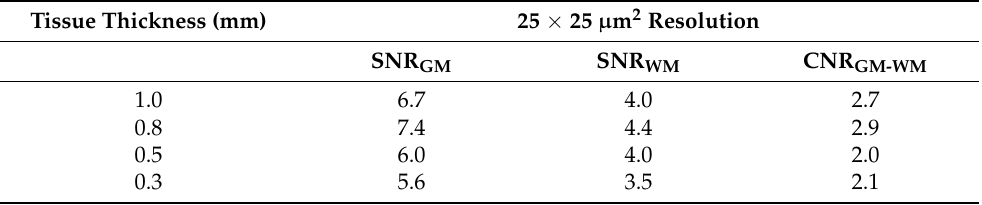
Table 1. Signal-to-noise and contrast-to-noise values for MRI images of thick tissue slices. SNR: signal-to-noise ratio; CNR: contrast-to-noise ratio; GM: gray matter; WM: white matter. Tissue Thickness